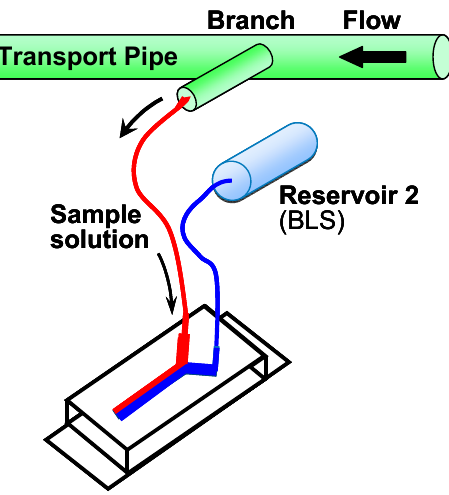
Figure 10. A schematic representation of application of the present system as an in-line pH measurement apparatus.